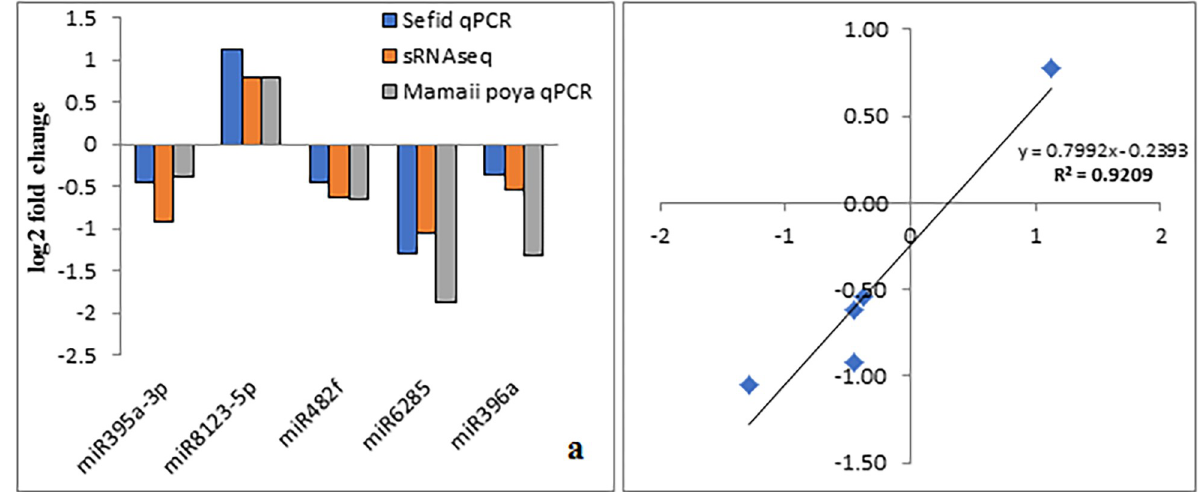
Fig 6. Illustrating of the qPCR confirmation results for the 5 selected miRNAs with differentially expression. (a) The X-axis demonstrate the selected 5 miRNAs and the Y-axis demonstrate the log2 fold change values derived from RNA-seq and qPCR. (b) Regression analysis of the log2 fold change values between RNA-seq and